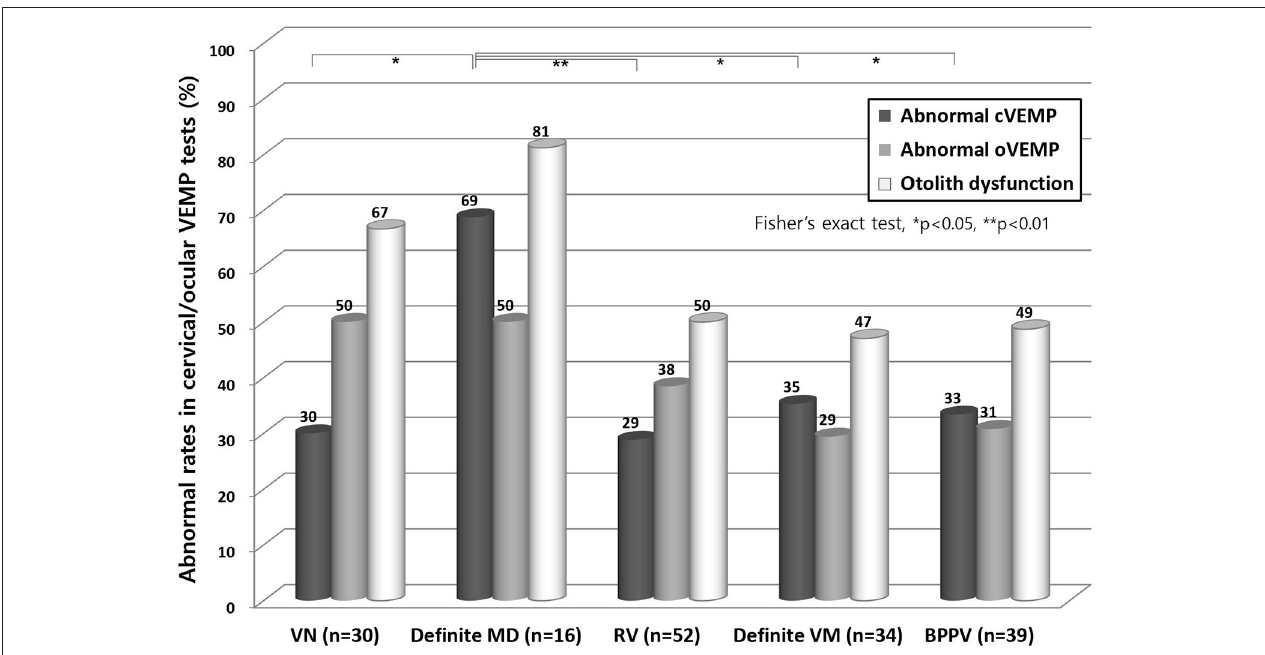
FIGURE 2 | Abnormal results from cervical VEMP and ocular VEMP test. In the cVEMP test, patients with a definite MD showed a higher abnormal rate than with any other disorder ( p < 0.05). In the oVEMP test, VN and definite MD cases showed the highest degree of abnormality, but this was not significantly different from other disorders. VN, vestibular neuritis; MD, Meniere’s disease; RV, recurrent vestibulopathy; VM, vestibular migraine; BPPV, benign paroxysmal positional vertigo; cVEMP, cervical vestibular evoked myogenic potential; oVEMP, ocular